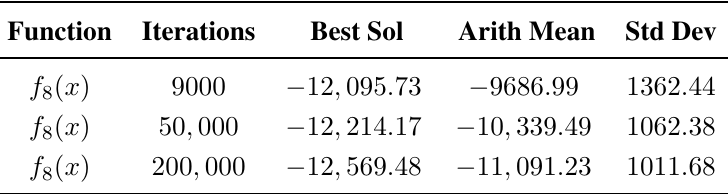
Table 3. Solutions found with different number of